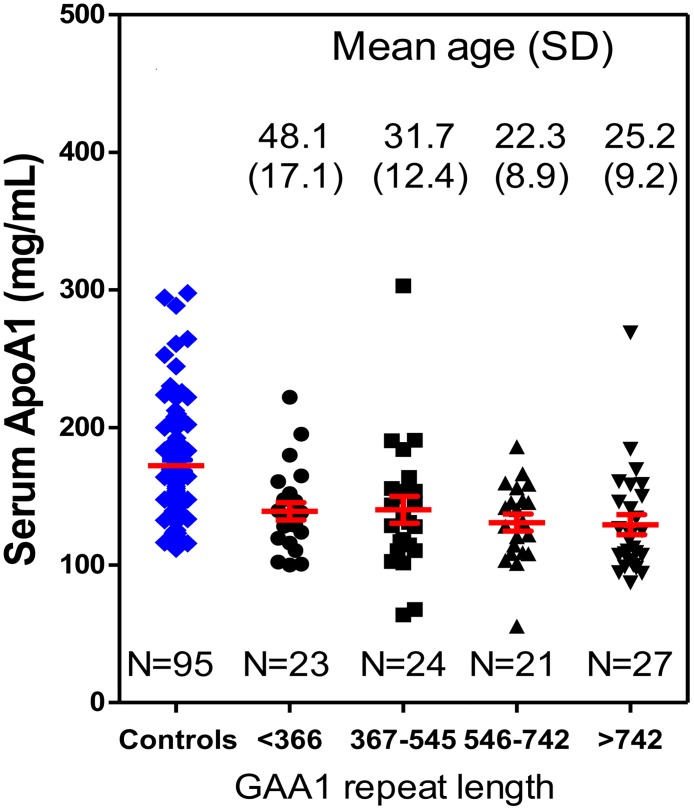
Analysis of serum ApoA-I concentrations.Relationship with GAA1 repeat length—95 controls, 23 FRDA cases 1st quartile, 24 FRDA cases 2nd quartile, 21 FRDA cases 3rd quartile, 27 FRDA cases 4th quartile.